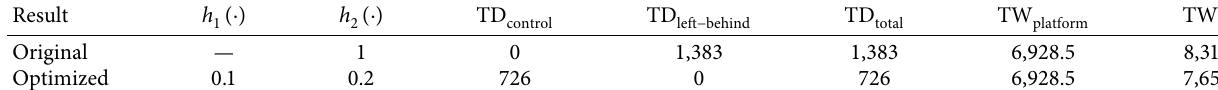
Table 10: The comparison of the optimized and original result (unit: minute).